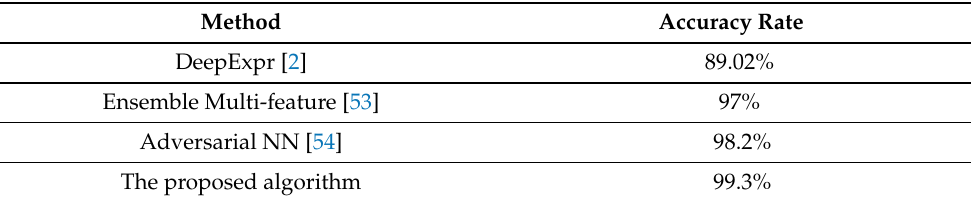
Table 2. Classification accuracy on the FERG dataset.